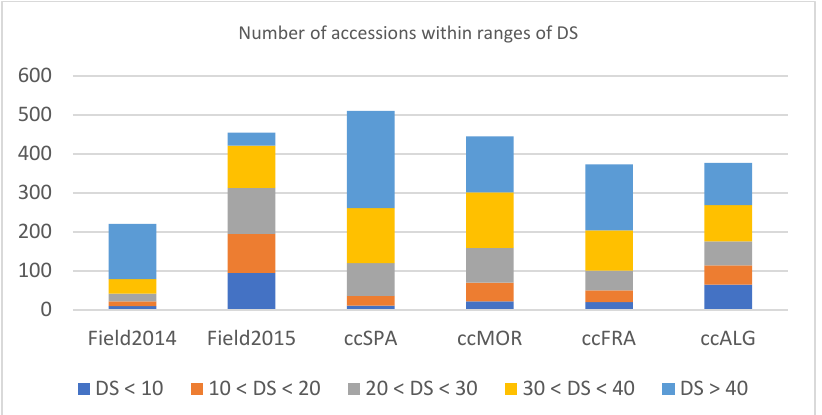
Figure 1. Phenotypic variation in rust response (DS) among Lens collection (525 accessions, different numbers studied on the different trials) after inoculation with U. viciae-fabae ex L. culinaris . Field2014 = adult plants in the field 2014; Field2015 = adult plants in the field 2015; ccSPA = seedlings under controlled conditions inoculated with isolate SPA; ccMOR = seedlings under controlled conditions inoculated with isolate MOR; ccFRA = seedlings under controlled conditions inoculated with isolate FRA; ccALG = seedlings under controlled conditions inoculated with isolate ALG.